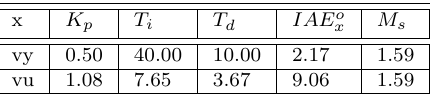
Table 8: Shows the reference controllers which mini- mizes the indices IAE vy and IAE vu , i.e. opti- mal output and input disturbance (ideal)